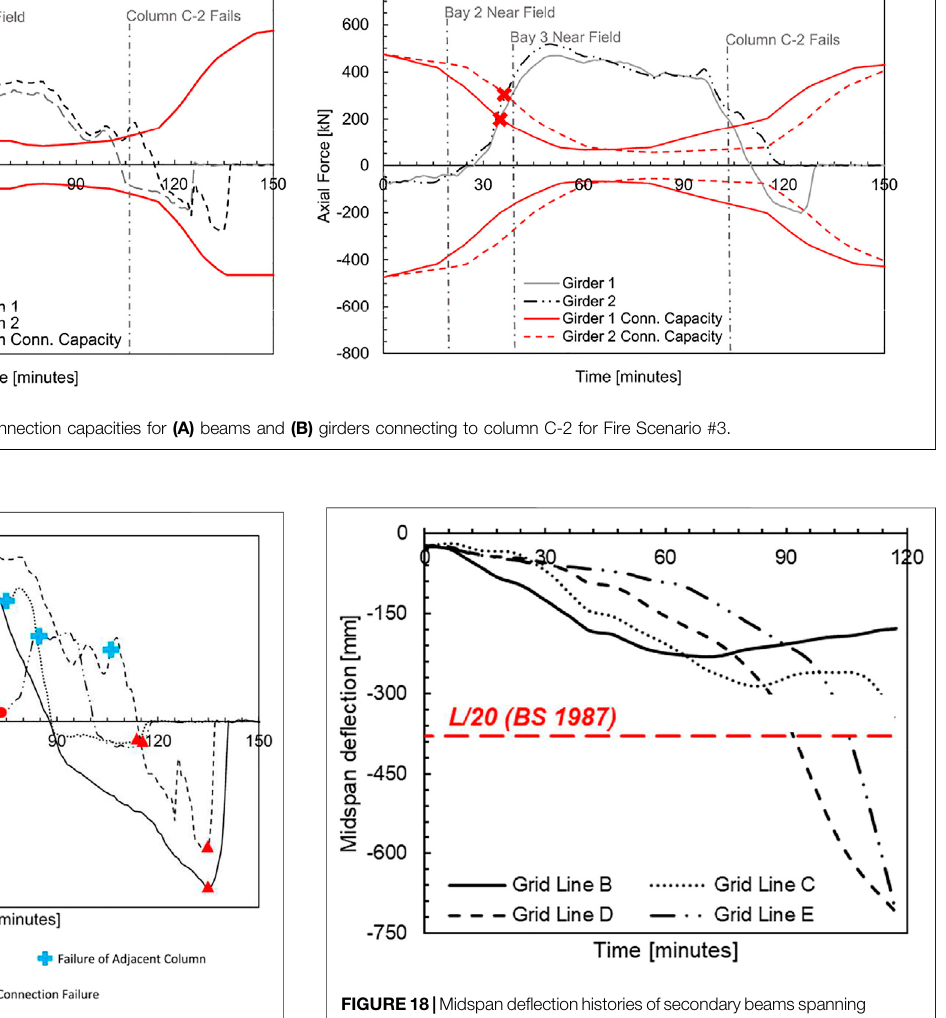
Frontiers in Built Environment |